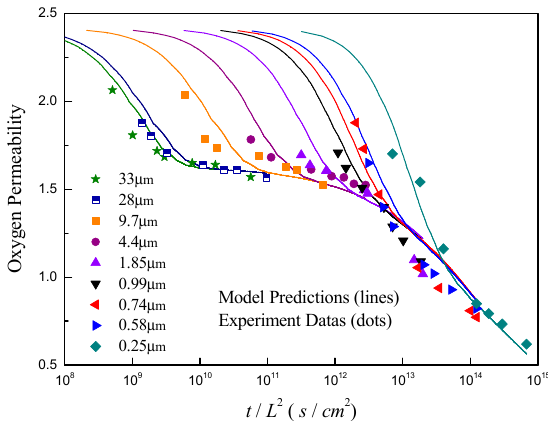
Figure 1. Model validation with experimental aging data for BPA–BnzDCA polymeric films with various thicknesses from 250 nm to 33 µm [21]. Table 1. Model parameters for bisphenol-A benzophenone-dicarboxylic acid (BPA-BnzDCA) films. Parameters